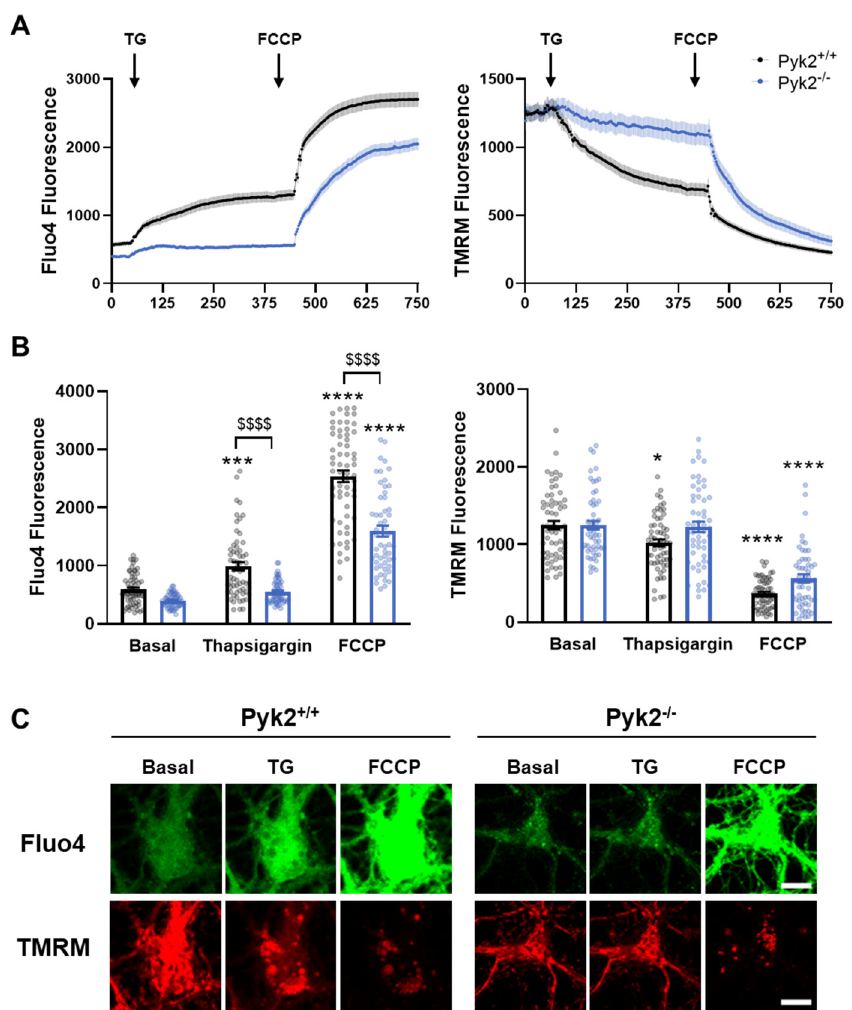
Figure 4. Regulation of cytosolic calcium levels is affected in hippocampal neurons devoid of Pyk2. Pyk2 +/+ and Pyk2 − / − primary neurons were loaded with Fluo4 (5 μ M) and TMRM (20 nM) to label intracellular calcium and mitochondrial membrane potential, respectively. Neurons were stimulated with thapsigargin (TG, 0.5 μ M) at 50 s and with FCCP (2 μ M) at 7.5 min. ( A ) Fluo4 and TMRM fluorescence traces from Pyk2 +/+ (black) and Pyk2 − / − (blue) throughout the experiment. Black arrows indicate the injection point of the treatment; ( B ) Quantification of fluorescence intensity of Fluo4 (left panel) or TMRM (right panel) at basal condition and after TG or FCCP treatment; ( C ) Representative confocal images of Fluo4 (green) and TMRM (red) fluorescence in basal conditions and after TG and FCCP exposure. Scale bar, 10 microns. Data are mean ± SEM. n = 55–62 neurons/genotype from 4 different cultures. * p < 0.05, *** p < 0.001, **** p < 0.0001 vs. basal Pyk2 +/+ ; $$$$ p < 0.001 vs. Pyk2 +/+ at each condition determined by two-way